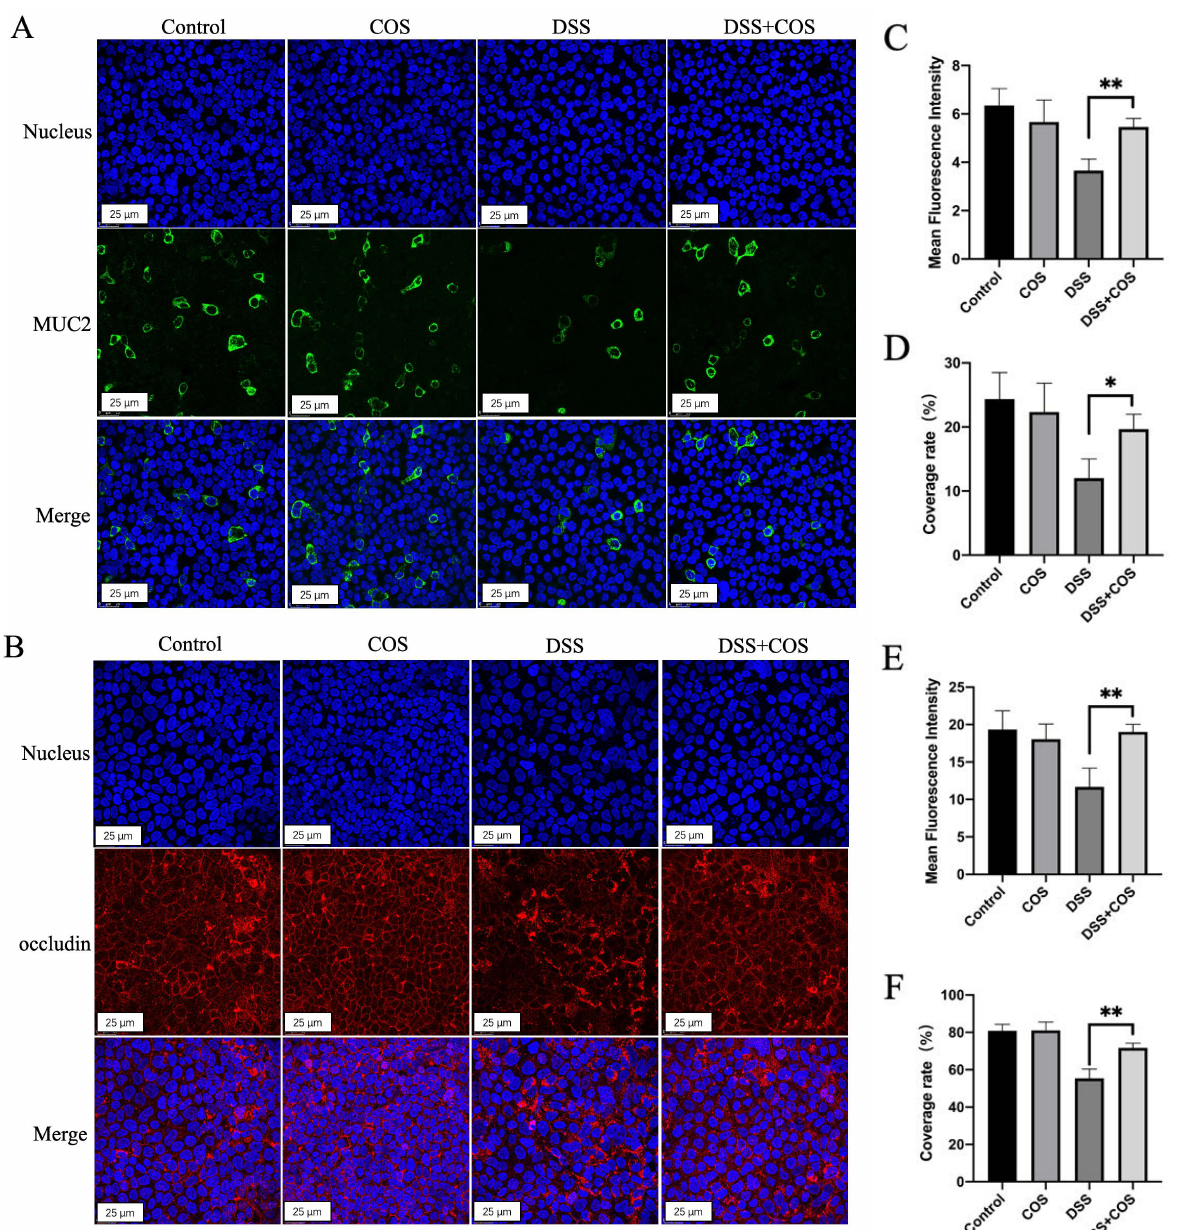
Figure 1. Effect of COS (chitosan oligosaccharide) on the expression of MUC2 and occludin in HT-29 and Caco-2 cells. ( A ) Immunofluorescence views of MUC2 (green) secreted by HT-29 cells in the control, COS, DSS (dextran sulfate sodium), and DSS + COS groups; ( B ) immunofluorescence views of occludin (red) secreted by Caco-2 cells in the control, COS, DSS, and DSS + COS groups; computerized quantification of the mean fluorescence intensity and the coverage rate of MUC2 ( C , D ) or occludin ( E , F ) was performed. The average value of randomly taken images was calculated ( n = 9, * p < 0.05, ** p < 0.01). Error bar represents the standard deviation. Images represent the typical situation of three independent experiments. Scale bars, 25 µ